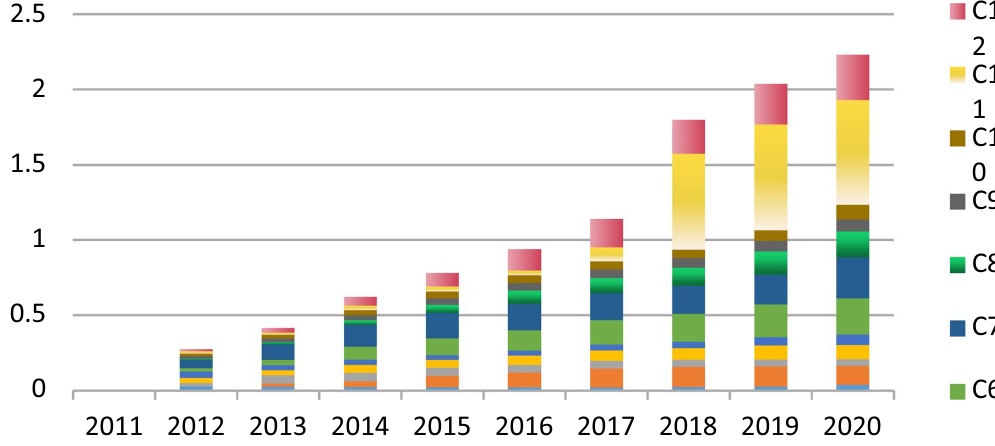
Figure.2. Variation trend chart in Anhui Province from 2011 to